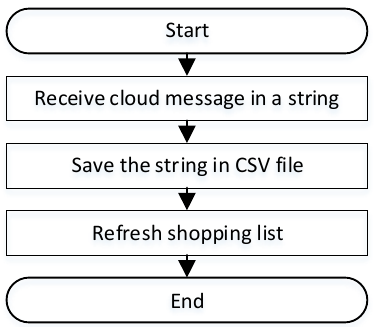
Figure 5. Flowchart of actions when the cloud message is received.